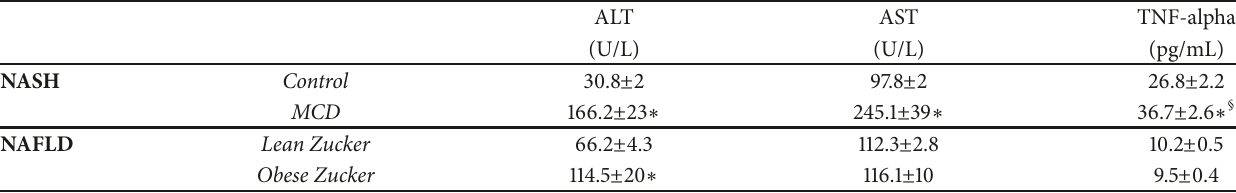
Figure 3: Hepatic content in TIMP-1 (a) and TIMP-2 (b) obtained from LL, ML, and RL in MCD and control rats. TIMP levels are expressed in ng/mL. Data are shown as mean values ± SE. ∗ p < 0.05. Table 1: Serum enzymes and TNF-alpha in NASH and NAFLD